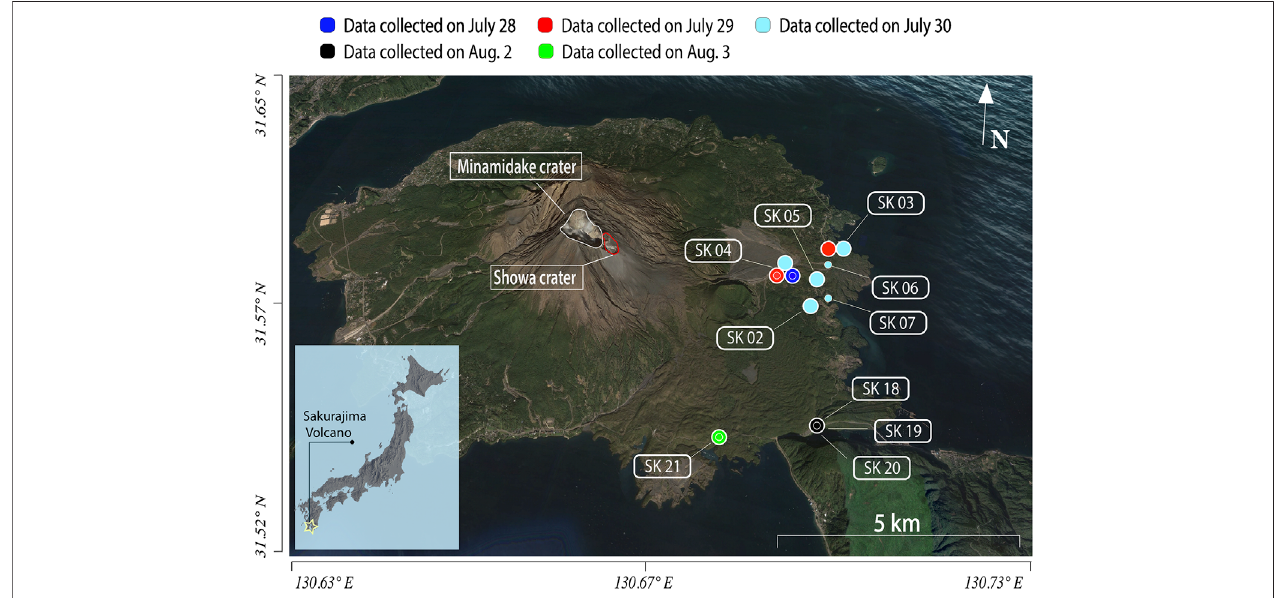
FIGURE 1 | The map shows the location of the tephra-fallout samples (large circles) and the position where the HS-HR video have been recorded (small circles).